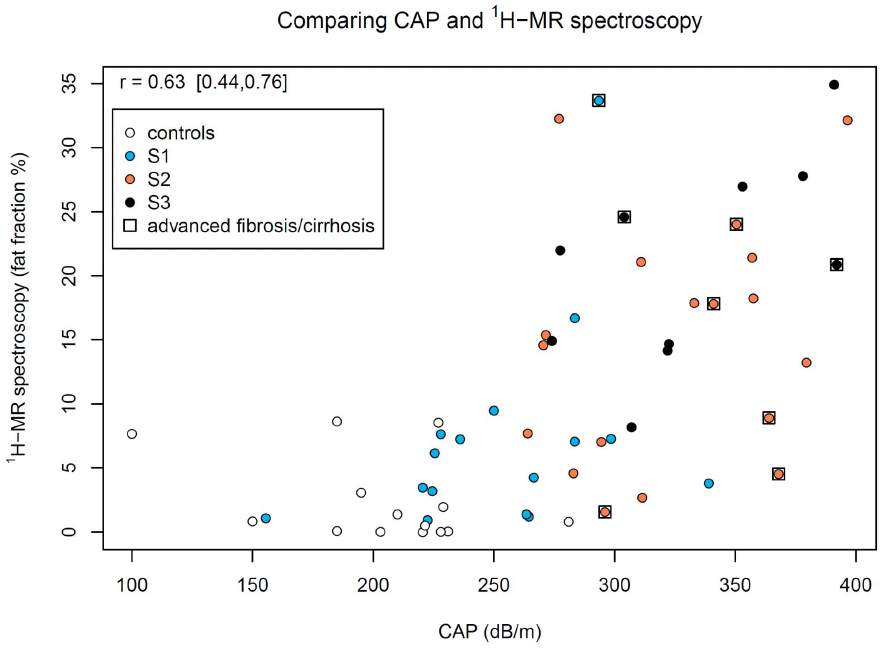
Figure 2. Correlation of CAP and 1 H-MRS. CAP and 1 H-MRS achieved only a modest correlation, especially in patients with concomitant fibrosis (labeled with squares). A total of 61 valid measurements were